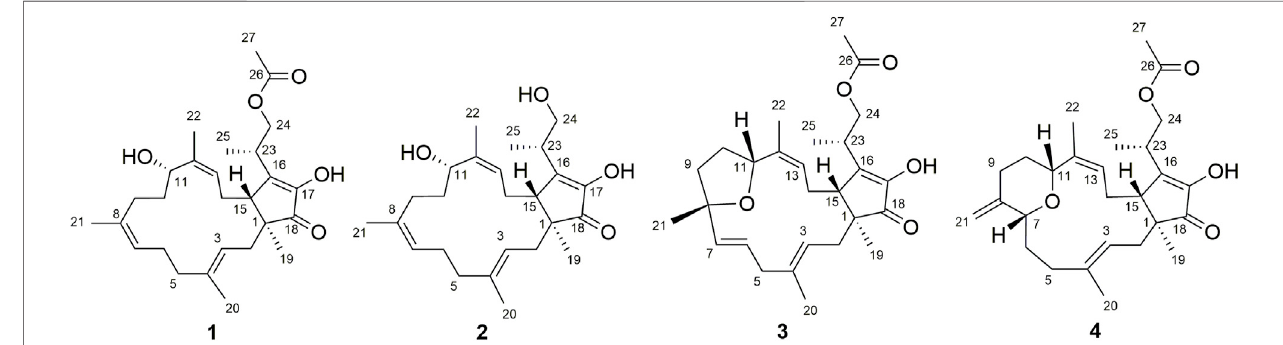
FIGURE 1 | Chemical structures of 1 – 4